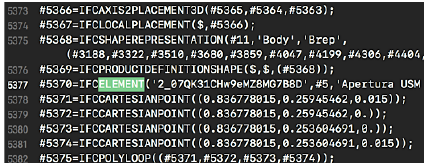
Figure 8. “ ifcbuildingelementproxy ” changed with “ element ”